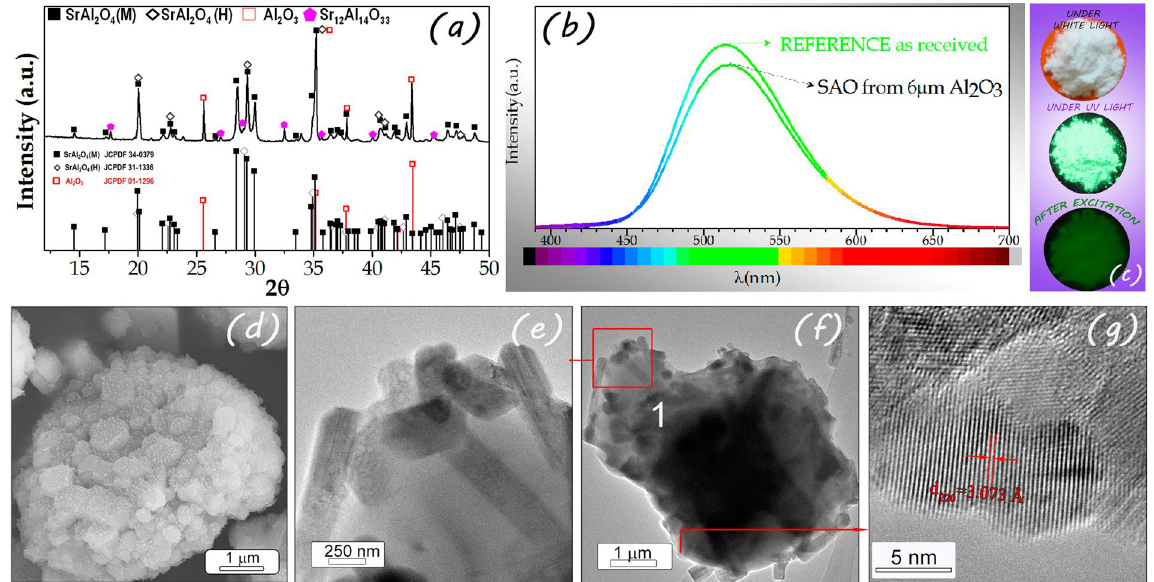
Figure 1. Structural, Microstructural, Morphological Characterization of the powder synthesized and their photoluminescent response. ( a ) XRD pattern of synthesized SrAl 2 O 4 :Eu, Dy (SAO) phosphor heated at 1000 °C for 2 h in 90N 2 -10H 2 atmosphere, employing a salt/SrAl 2 O 4 molar ratio of 3:1 as precursor an alumina with an average particle size, d 50 ≈ 6 μ m. The symbols highlight Al 2 O 3 (red-open squares), SrAl 2 O 4 (Hexagonal) (black- open diamonds), and SrAl 2 O 4 (Monoclinic) (black squares). The standard diffraction pattern (JCPDS 34-0379) of SrAl 2 O 4 monoclinic polymorph, (JCPDS 31-1336) of SrAl 2 O 4 hexagonal polymorph and (JCPDS 01-1296) of Al 2 O 3 are also plotted at the bottom of the figure. ( b ) Emission spectra upon excitation at 380 nm of synthesized SrAl 2 O 4 :Eu, Dy detailed in Fig. 1(a) and compared with the commercial powder (from Jinan Chenghao Technology Co., Ltd) as received. ( c ) Photographs of the powders under white light excitation (upper-image), under UV light excitation (middle-image) and in dark after being stimulated with light (bottom-image). ( d ) FE- SEM and ( e–g ) TEM and HRTEM micrographs of the synthesized